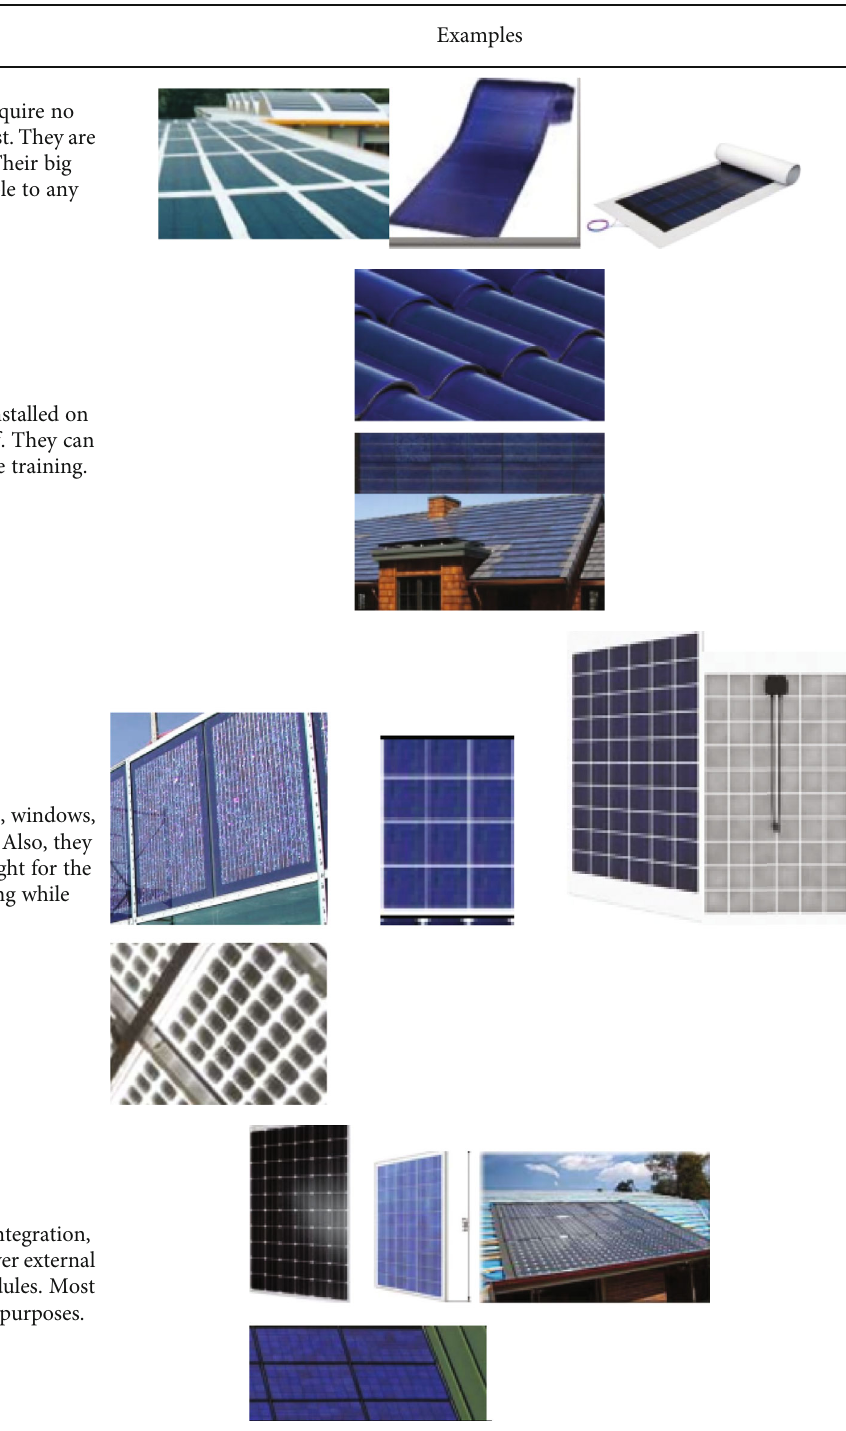
Table 2: Market names according to the